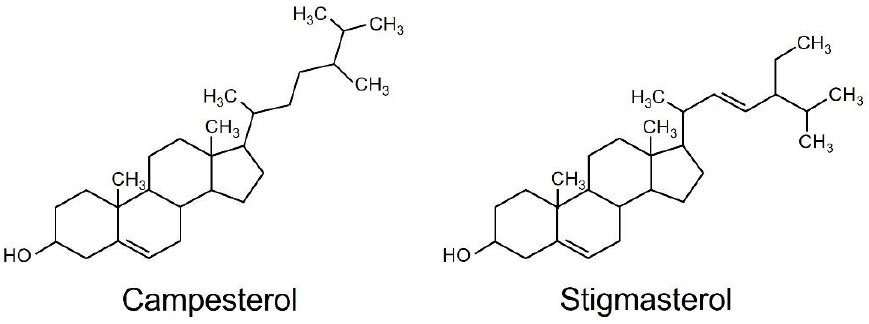
Figure 1. Effects of fractions obtained from an acetone extract of sclareol-treated plants on the accumulation of chlorophyll in Arabidopsis leaves. Sclareol-treated Arabidopsis plants were extracted with acetone. The extract was divided